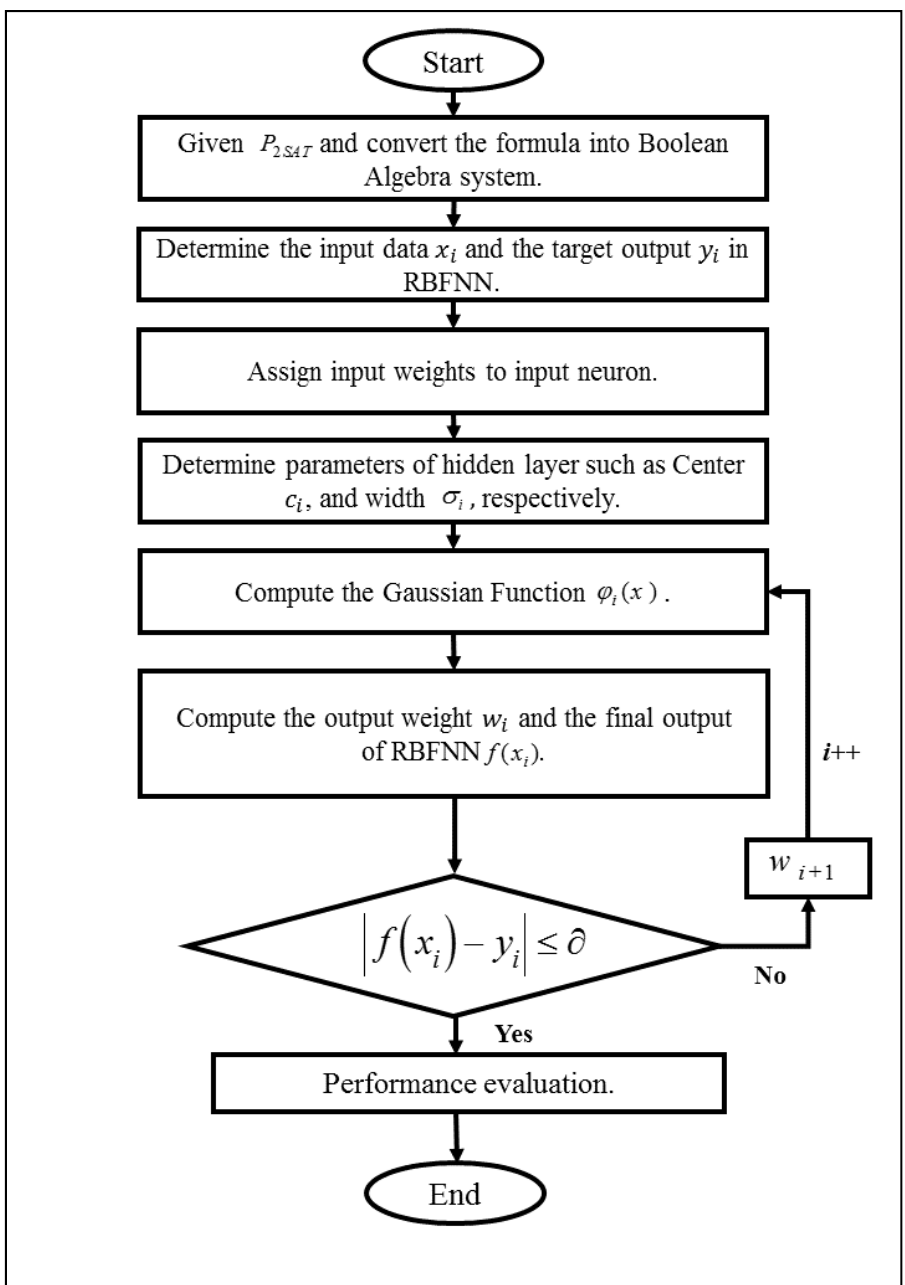
Figure 1. The implementation